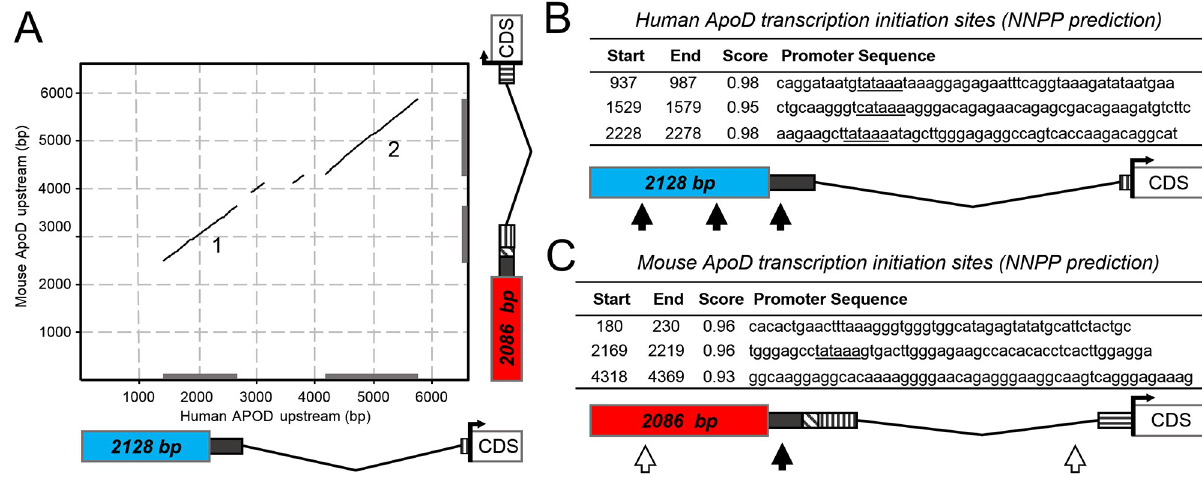
Fig 5. Promoter predictions for the mouse ApoD gene (I). A) Dot matrix representation of a pairwise alignment of human vs. mouse ApoD upstream gene sequences, covering approximately 6000 bp upstream of the CDS start site and comprising 5’ UTR and the reported/predicted human/mouse promoter regions (colored rectangles). Black and striped boxes indicate ExonScan predicted 5’ UTR exons. Region 1 matches a big portion of the reported human promoter and maps to the first mouse 5’ UTR exons. Region 2 locates in the 5’ UTR long intron in both genes. Only diagonals with p < 0.001 are shown. B) The table shows three potential initiation transcription sites in human ApoD locus (black arrows in the diagram) detected by a neural network prediction algorithm. The third one lies within the first 5’ UTR exon. Predicted TATA boxes appear underlined. C) Three potential transcription initiation sites are detected in mouse ApoD locus. The second one lies in the 5’ UTR, in a region similar to the reported human promoter, and contains a predicted TATA box (black arrow in the diagram). Two other initiation sites (white arrows) do not contain a TATA box, including the site located in the large